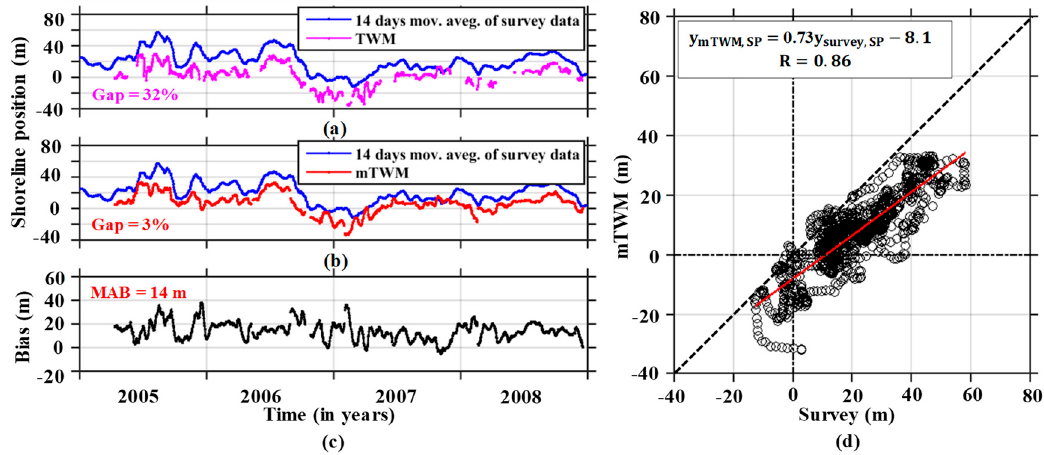
Figure 11. The temporal variations in the shoreline positions (SP) estimated from ( a ) the survey data and TWM and ( b ) the survey data and mTWM derived results (at x = − 49 m), ( c ) the bias between the survey and mTWM results, and ( d ) the scatter plot of survey vs. mTWM. The red line represents the linear fitting line.